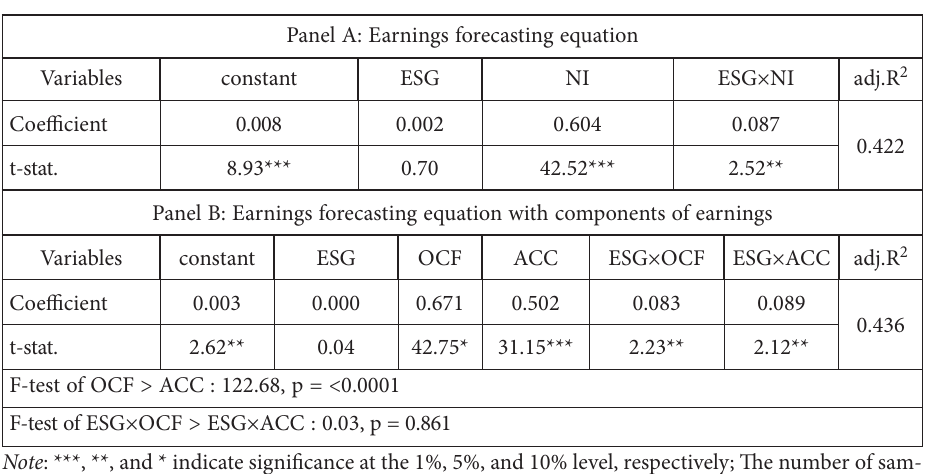
Table 6. Sustainable management activities and the persistence of sustainable management